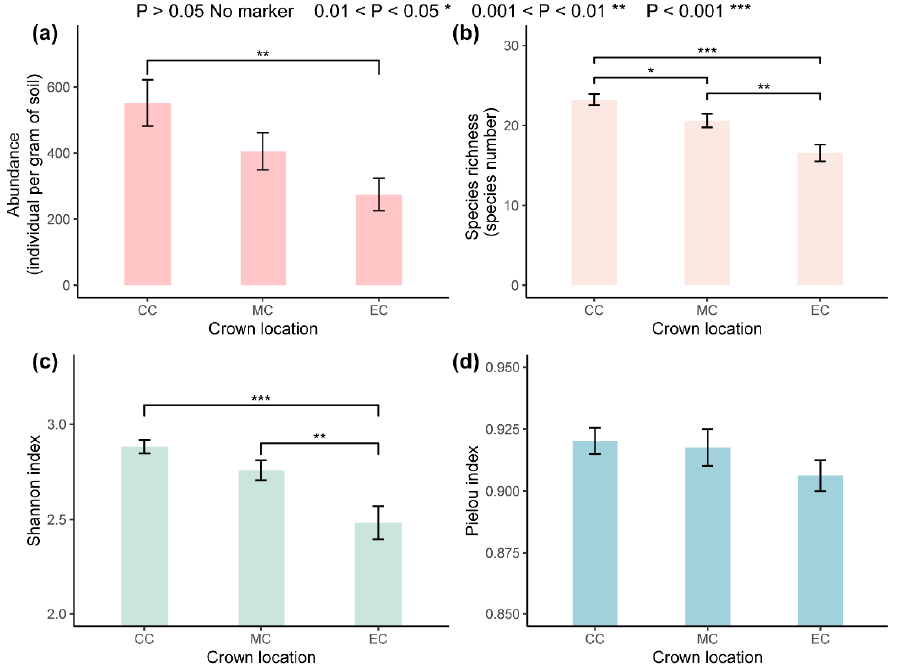
Figure 6. Overall community characteristics (mean ± SE) of the TA communities under the three crown positions (CC — the center of the crown, MC — the middle of the crown, EC — the edge of the crown) [( a ) The abundance of TA communities at the three crown positions; ( b ) The species richness of TA communities at the three crown positions; ( c ) The Shannon’s diversity index of TA communities at the three crown positions; ( d ) The Pielou’s evenness index of TA communities at the three crown positions].